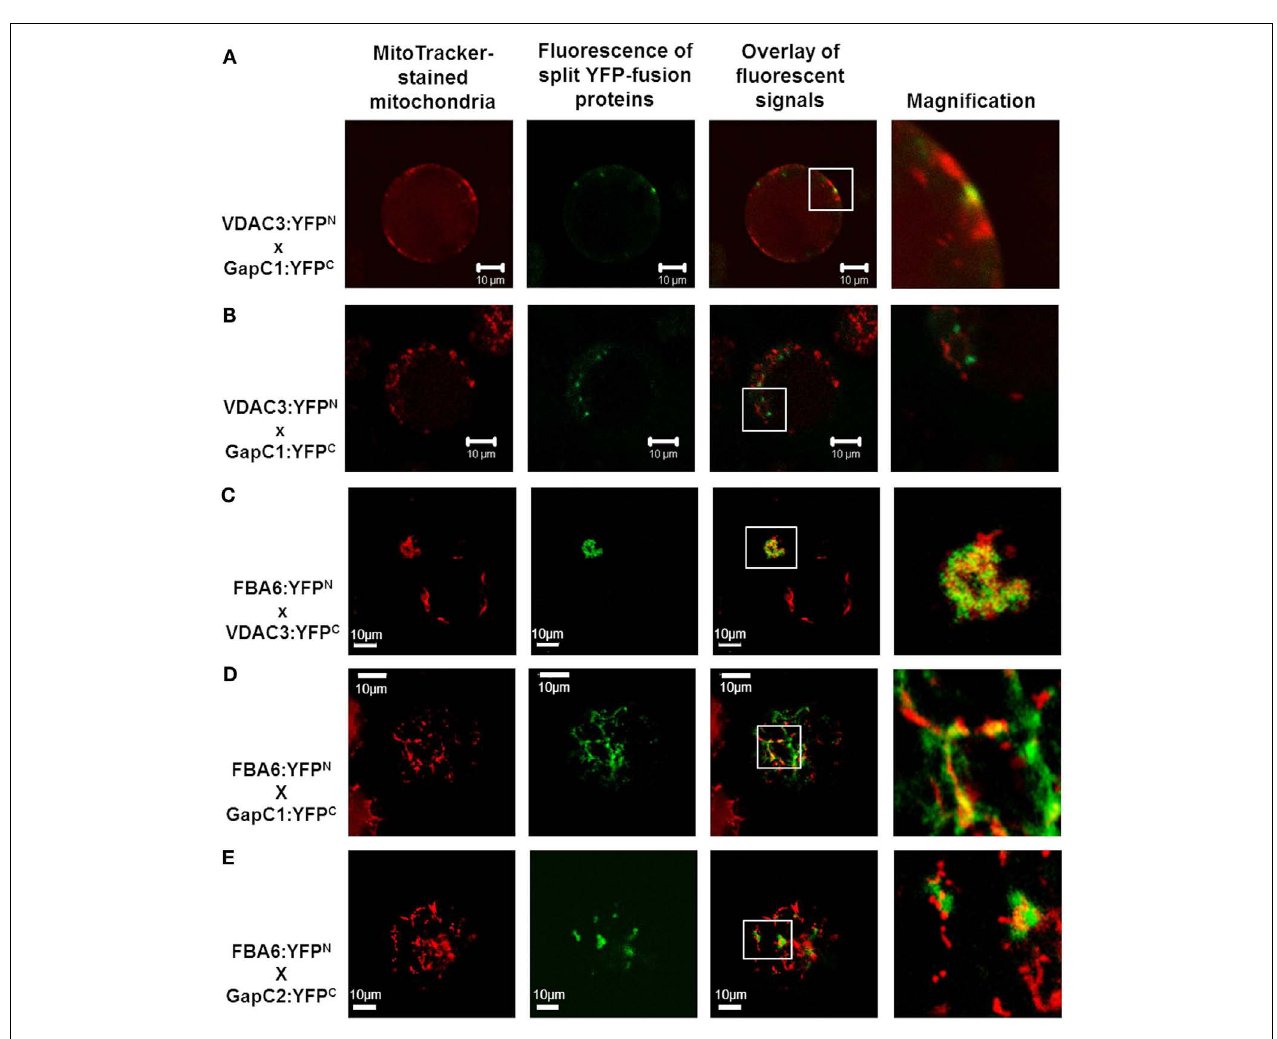
VDAC3 (C) , as well as FBA6 with GapC1 or GapC2 (D,E) , fused with N- or C-terminal halves ofYFP, respectively, were tested for mitochondrial localization by staining the cells with 50nM MitoTracker® Orange CMTMRos (Molecular